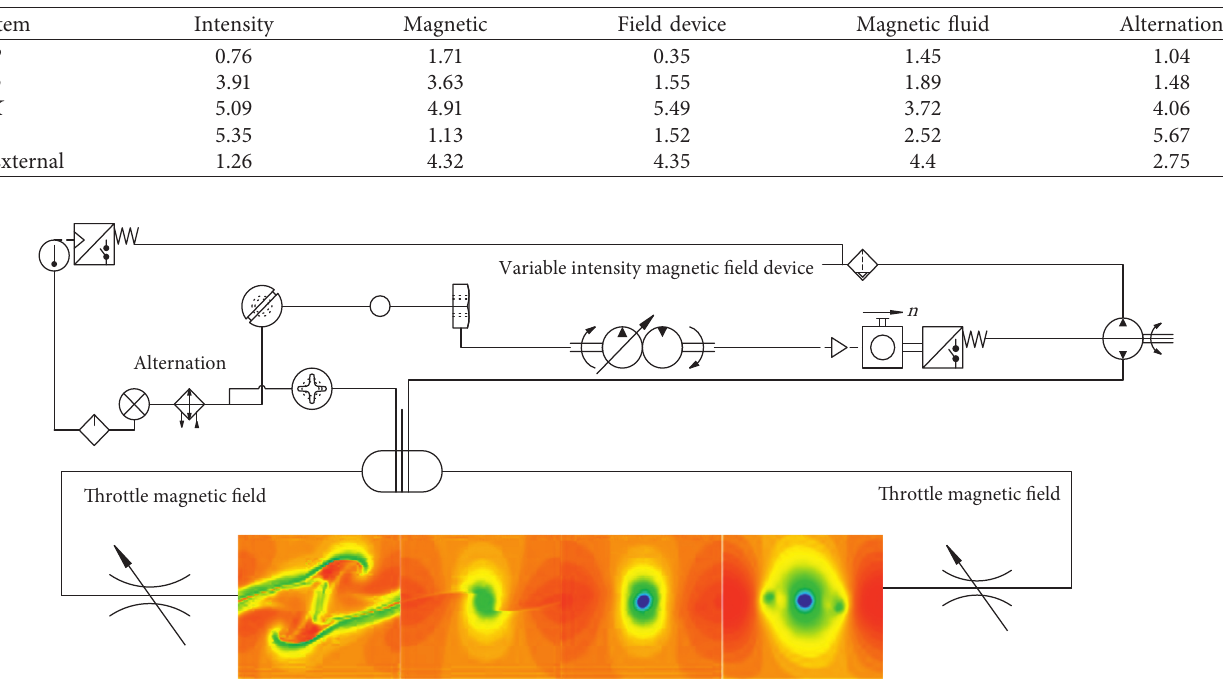
Table 1: The relationship between viscosity coefficient η and volume fraction φ .